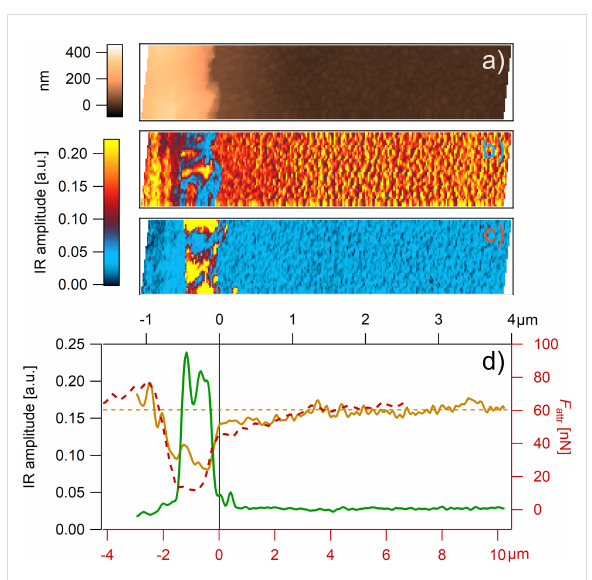
Figure 6: AFM-IR measurements. (a) AFM height, (b) IR amplitude at 1512 cm − 1 , and (c) IR amplitude at 1070 cm − 1 . (d) Average of the IR amplitude at 1512 cm − 1 (brown line) and at 1070 cm − 1 (green line). For comparison, averaged F attr values are shown (red dashed line) as a function of x (distance to the boehmite structure). The AFM-IR mea- surements were performed with the tip